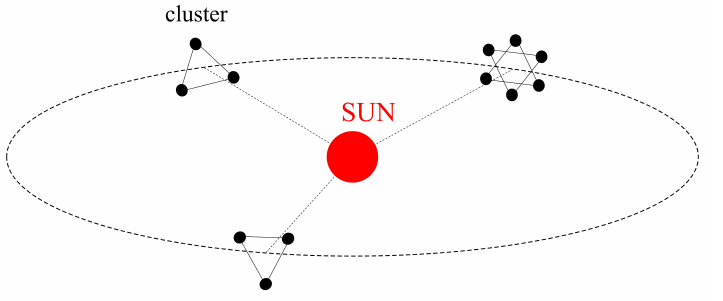
Figure 1. Schematic geometry of DECIGO. It consists of four clusters along the heliocentric orbit of the earth. Each cluster is composed of three differential Fabry–Perot (FP) Michelson interferometers arranged in an equilateral triangle. Two clusters are placed in the same position for detecting the primordial GWs, and the other two spaced along the orbit to enhance the angular